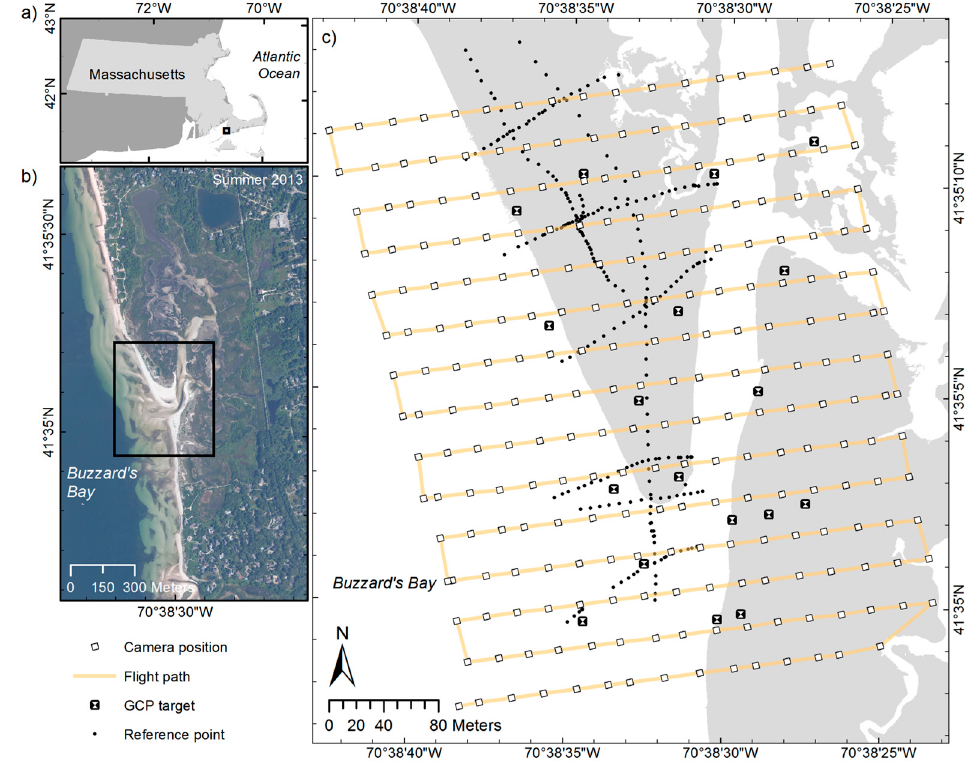
Figure 2. Local context of study area in ( a ) Massachusetts (black square) and ( b ) along the Buzzards Bay coast displayed with aerial imagery acquired in summer 2013 (2013 Massachusetts DEP Natural Color Imagery collected for NOAA, NOS, OCM between 28 May 2013 and 9 September 2013). ( c ) Map of the survey at Black Beach, MA: black and white squares indicate the locations of targets used as ground control points (GCPs); black dots represent 254 independent reference points; the orange line represents the path flown at approximately 35 m altitude by the UAS (not including take off and landing sequences); and white squares within the flight path represent the location of the camera at the time of capturing each